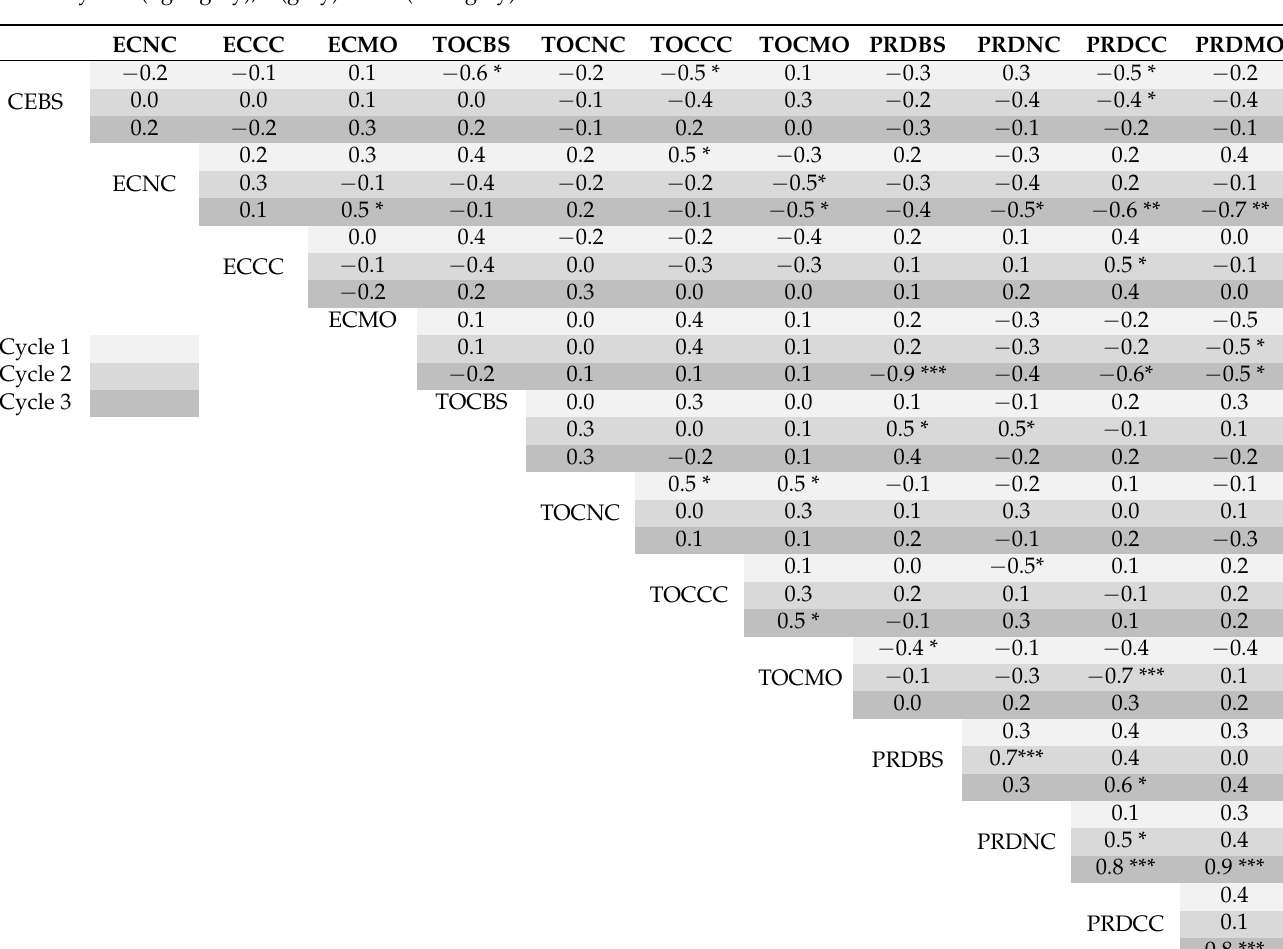
Table 5. Spearman correlation matrix. Among soil electrical conductivity (EC), total organic carbon (TOC) and productivity (PRD), under different soil cover conditions, bare soil (BS), natural cover (NC), coconut coir (CC), and moringa (MO), for the following combinations: ECBS, ECNC, ECCC, ECMO, TOCBS, TOCNC, TOCCC, MOTMO, TOCMO, PRDBS, PRDNC, PRDCC, and PRDMO. The significance for the correlation coefficient is based on ( p < 0.001 (***); p < 0.01 (**) and p < 0.05 (*)), for cycle 1 (light gray), 2 (gray) and 3 (dark